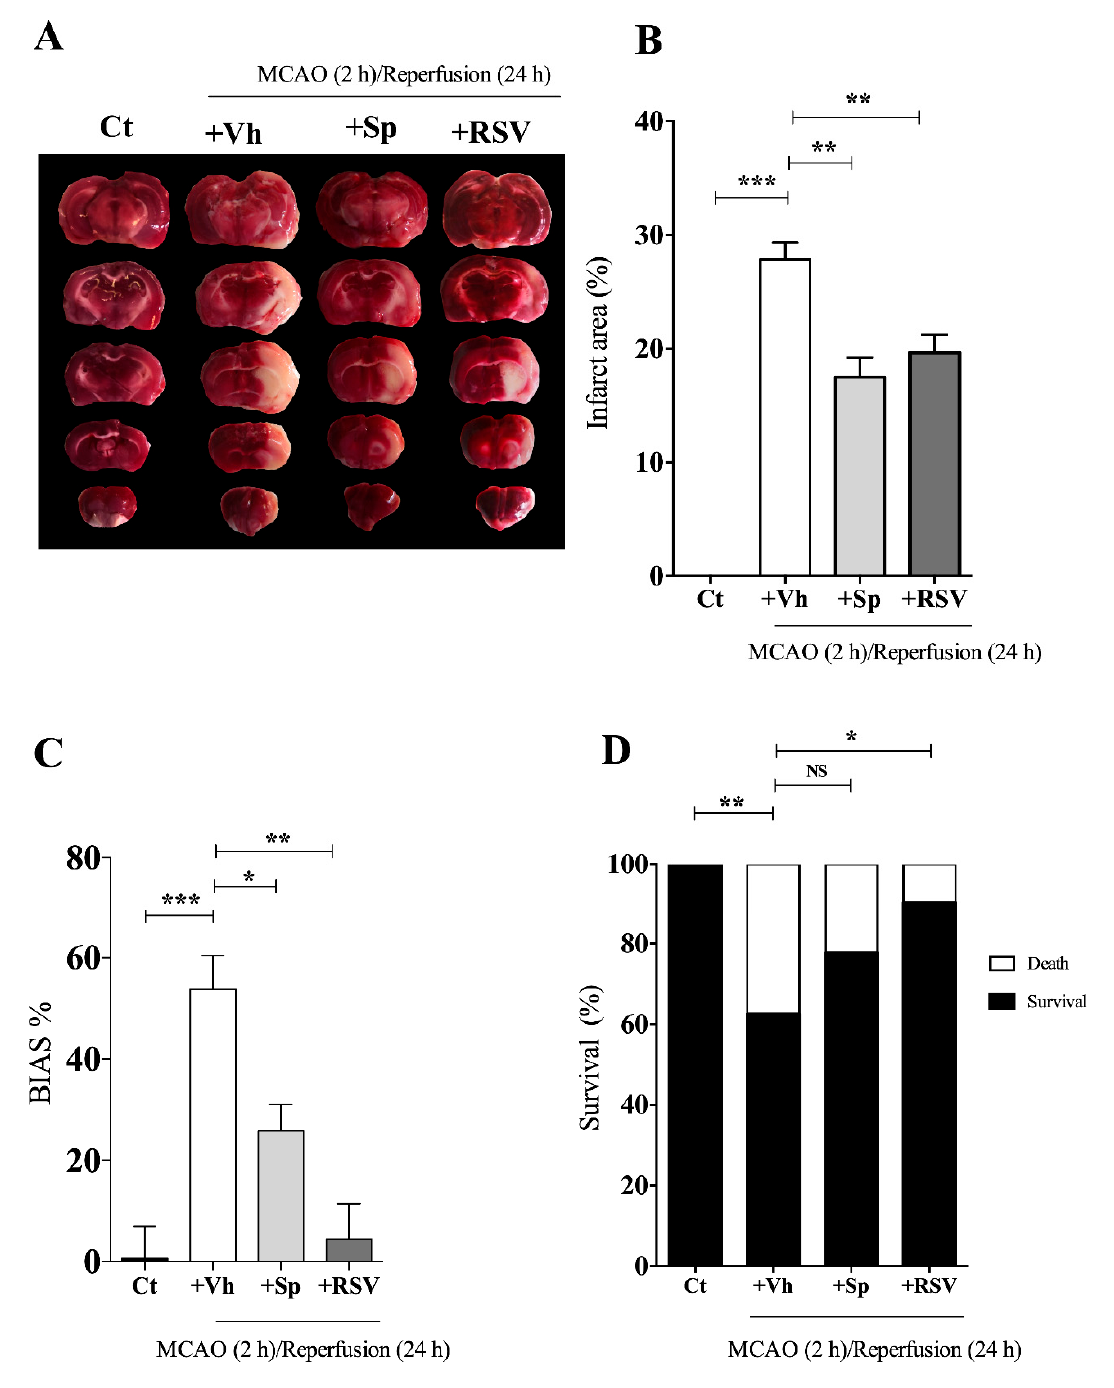
Figure 4. Salvia polystachya (Sp) extract from the Lamiaceae family prevents damage induced by cerebral ischemia. Animals were subjected to 2 h of ischemia by middle cerebral artery occlusion (MCAO) and followed by 24 h of reperfusion ( n = 6–10). Sp extract was added at the beginning of the reperfusion (3 mg/kg; diluted in 50% ethanol; intravenous via). Control (Ct); Vehicle (+Vh); Vehicle + Sp extract (+Sp). (A) Effect of the treatment with Sp on the infarct area. Infarct area was evaluated in coronal brain sections by the 2, 3, 5-triphenyltetrazolium chloride (TTC) dye test. (B) Quantification of the infarct area. (C) Evaluation of neurological deficit. The global use score of extremities (BIAS) was calculated by subtracting the percentage of contacts of the altered limb to the percentage of the not altered limb. (D) Survival. Results were expressed as mean ± SEM; ANOVA and Tukey test: upper bars indicated the groups that present differences, *** p < 0.0001; ** p < 0.001; * p < 0.05. NS, non- significant.